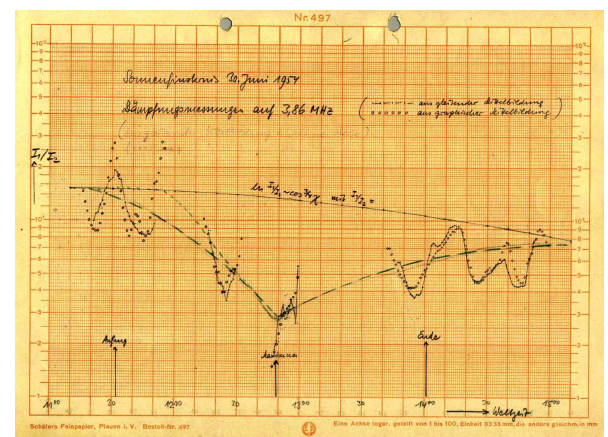
Figure 13. First results of absorption measurements with the A1 method at Juliusruh during the solar eclipse of 6 June 1954, 13:00– 15:00GMT.